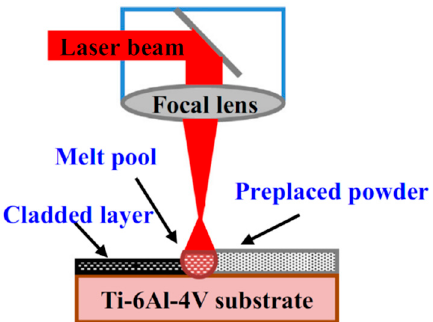
Figure 12. Laser cladding (LC) schematic diagram [90]. Reprinted with permission from reference [90] 2018 Elsevier.